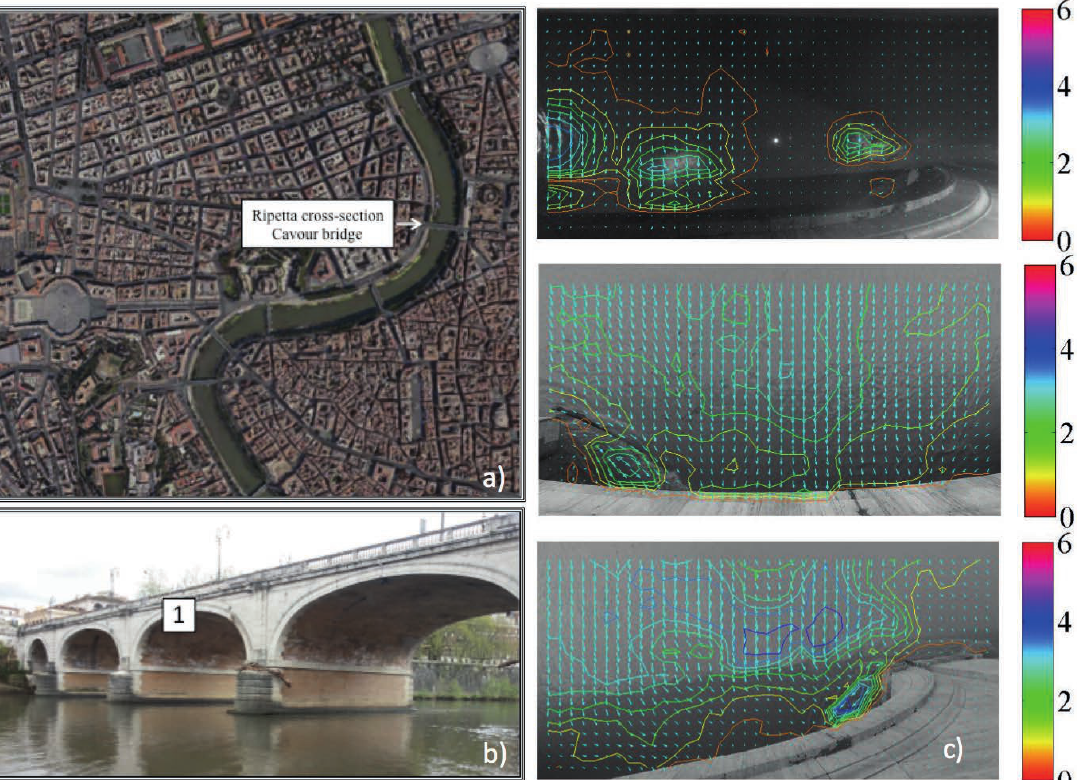
Fig. 1 (a) Map of the Tiber River in the Rome urban area, displaying the location of the hydrological cross-section. (b) View of Cavour Bridge; the experimental apparatus are located in “1”. (c) Time averaged surface flow velocity maps for the three tests (1, 2 and 3 from top to bottom). Values are in